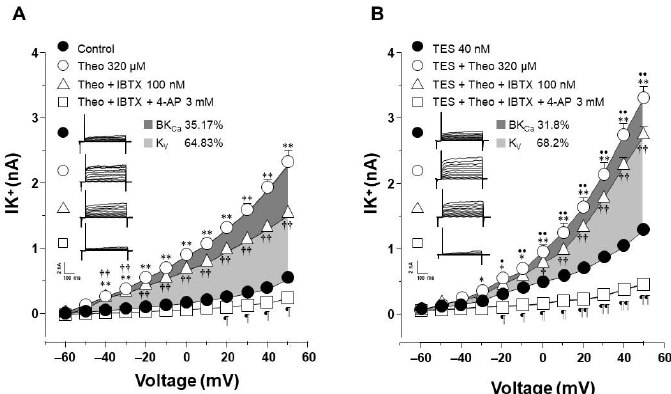
Figure 6. Administration of iberiotoxin followed by 4-aminopyridine shows the same pattern that voltage-gated delayed K + channels (KV) are the major contributors to the enhanced theophylline- induced K + currents after testosterone (TES) treatment. ( A ) Application of theophylline (Theo) 320 μM to single myocytes under control conditions (not incubated with TES) markedly incre ased the IK + from − 50 mV ahead. This increase was slightly reduced by iberiotoxin (IBTX, 100 nM), a specific blocker of BK Ca channels. Successive administration of 4-aminopirydine (4 AP, 3 mM), a blocker of K V channels, to the same cells abolished the remaining Theo-induced increase of IK + from − 40 mV ahead ( n = 6). BK Ca channels account for 35.17% of the theophylline response, according to an esti- mation of the area under the curve (AUC) (light gray region), while K V channels account for 64.83%. (dark gray area). ( B ) When myocytes were incubated with TES 40 nM, the addition of IBTX (100 nM) reduced the Theo-induced K + current by 31.8% (light gray area), whereas the addition of 4-AP (3 mM) eliminated the theophylline-triggered rise in IK+ enhanced by TES, indicating a major role of K V channels (68.2%, dark gray area) in the androgen action ( n = 6). These results also suggest that TES upregulates these proteins. Symbols depict the mean ± S.E.M. In panel ( A ), ** p < 0.01 when comparing Control (●) vs. Theo (o) groups. †† p < 0.01, comparing Control (●) vs. Theo + IBTX (Δ). ¶ p < 0.05 comparing Cont rol (●) vs. Theo + IBTX + 4- AP (□). In panel ( B ), ** p < 0.01 and * p < 0.05 when comparing TES (●) vs. TES + Theo (o) groups. † p < 0.05, †† p < 0.01, comparing TES (●) vs. TES + Theo + IBTX (Δ). •• p < 0.01, • p < 0.05, comparing TES + Theo (o) vs. TES + Theo + IBTX (Δ)